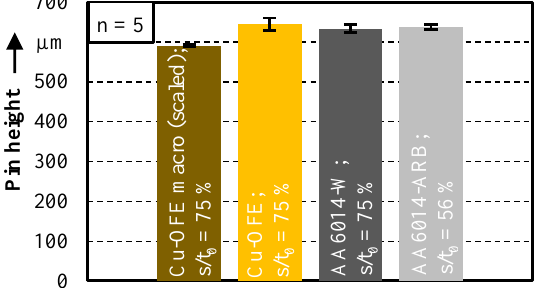
Figure 4. Pin heights after extrusion stage 1 for macro (scaled) and micro scale